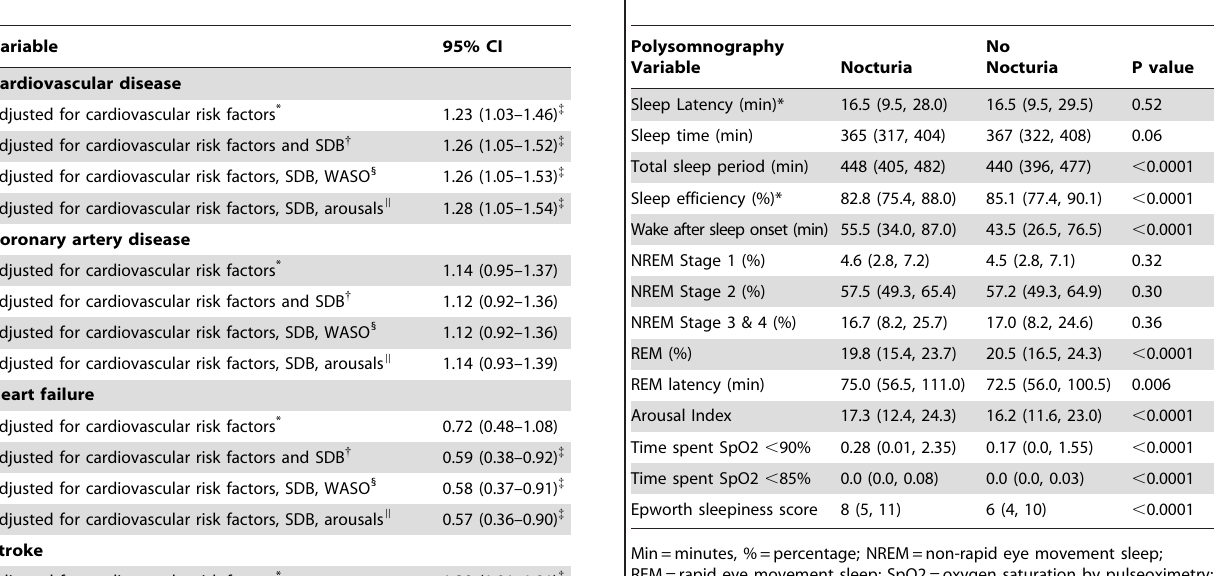
Table 5. Adjusted Odds Ratios Of Associations Between Nocturia and Prevalent Cardiovascular Morbidity.